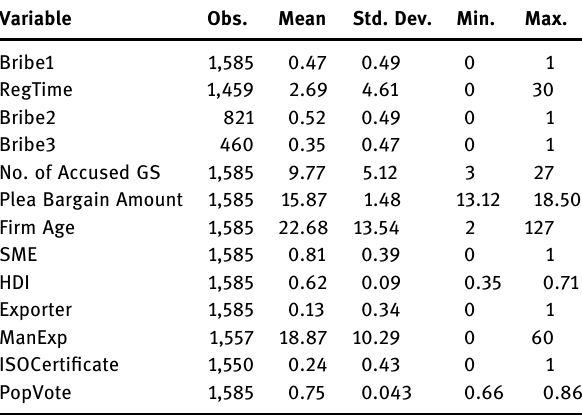
Table 2: Summary statistics ( baseline complete case sample